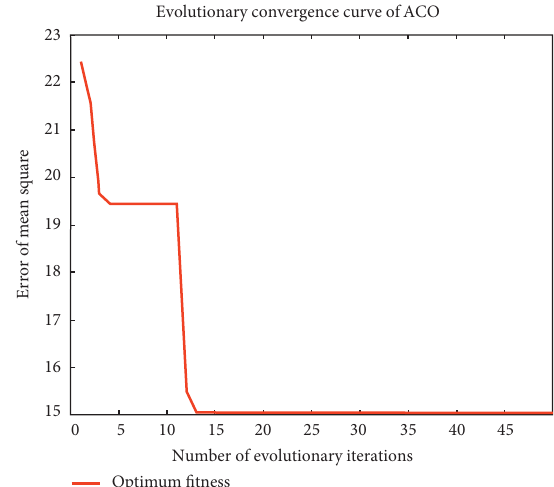
Figure 25: Volumetric shrinkage fit comparison.